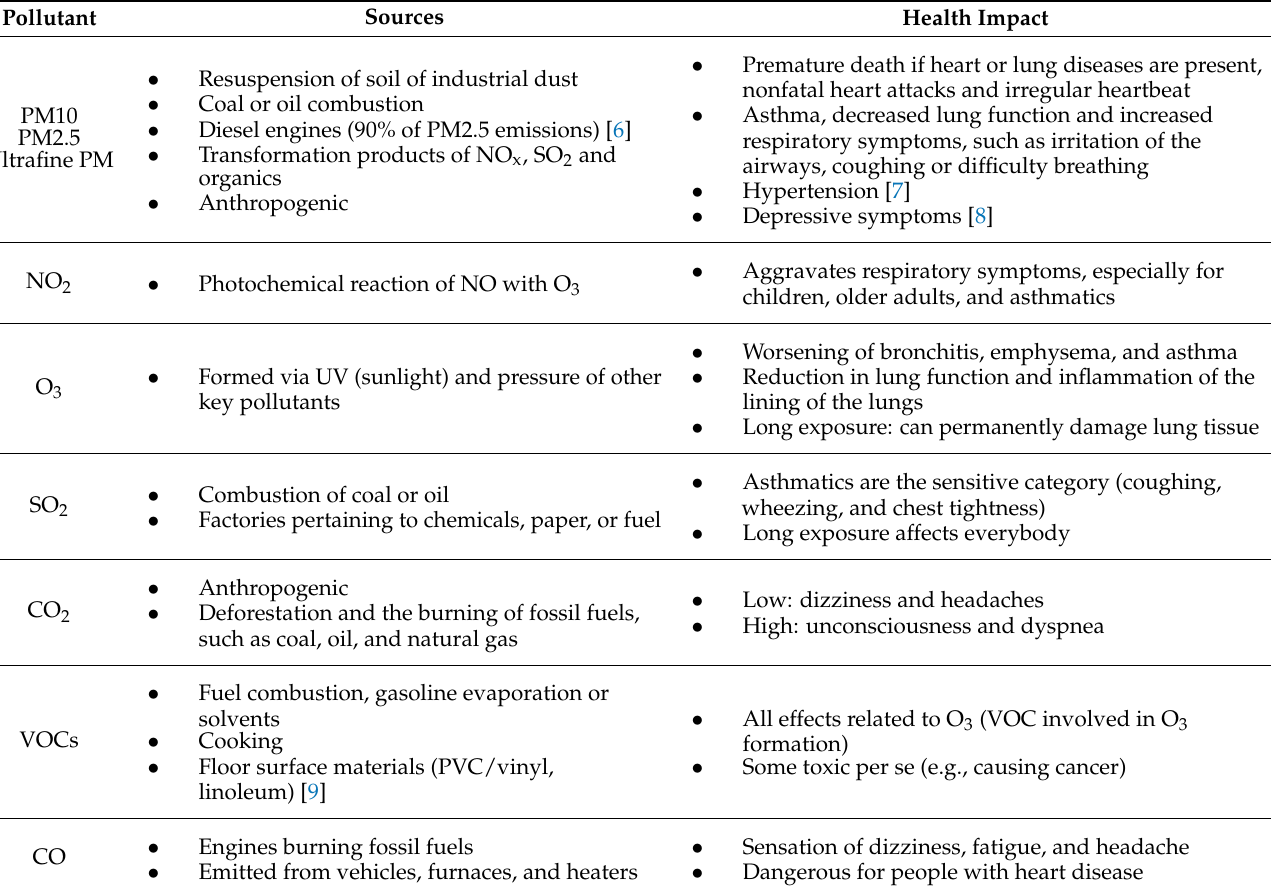
Table 1. Summary table of the major pollutants, their sources and their impact on human